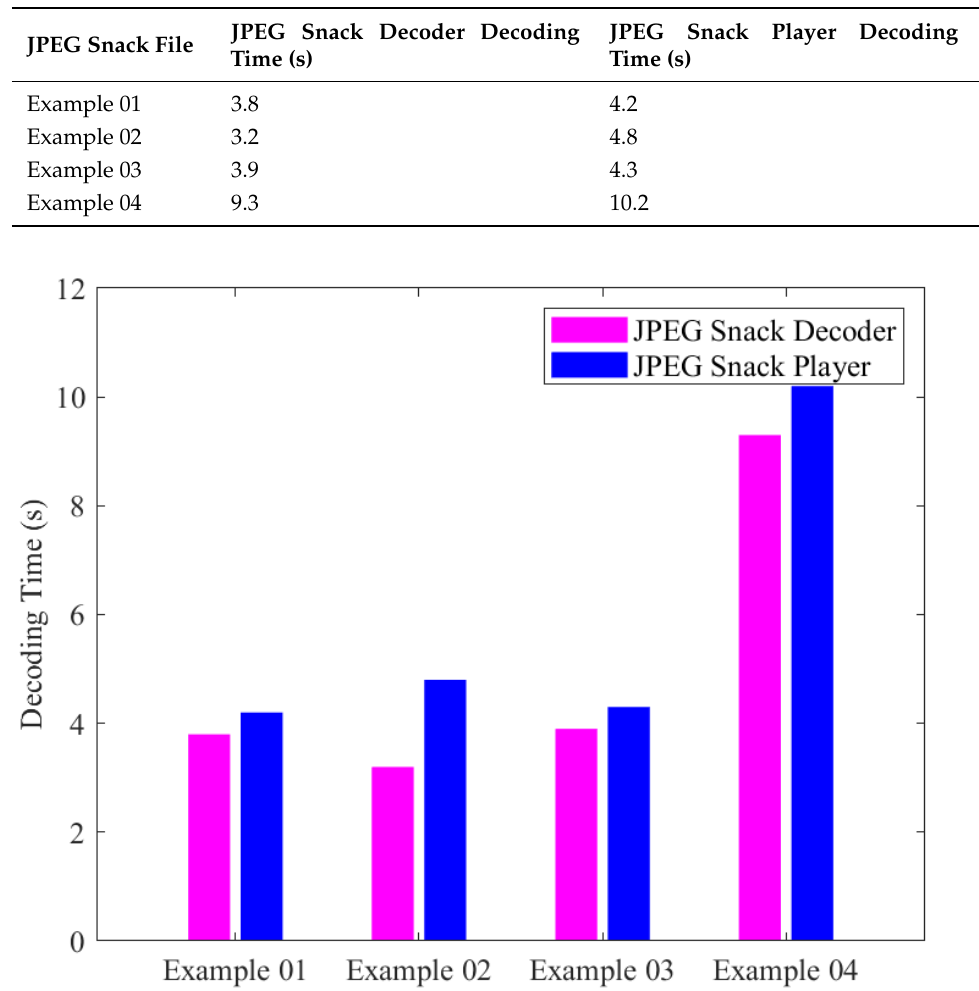
Figure 12. JPEG Snack Decoder and JPEG Snack Player Decoding